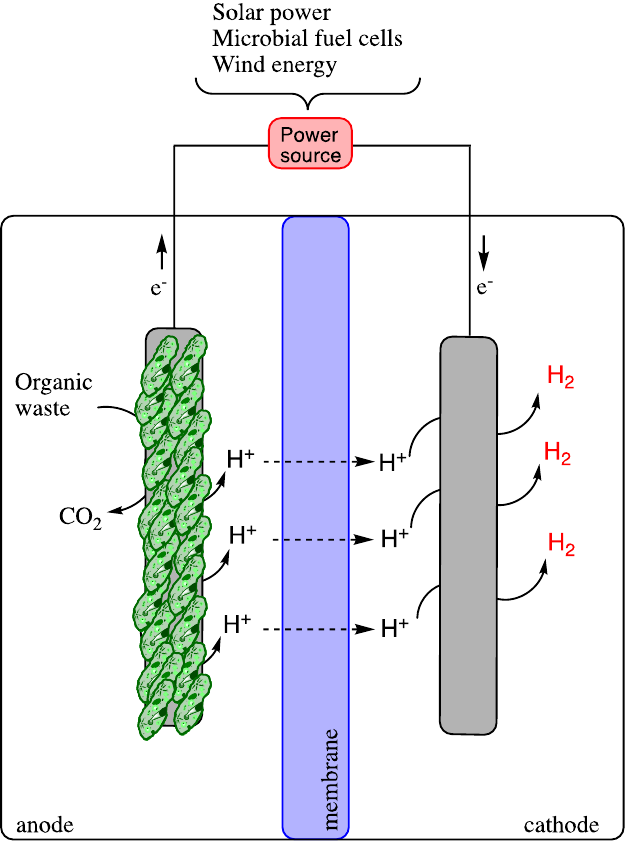
Figure 5. Schematic diagram of a microbial electrolysis cell for H 2 production.